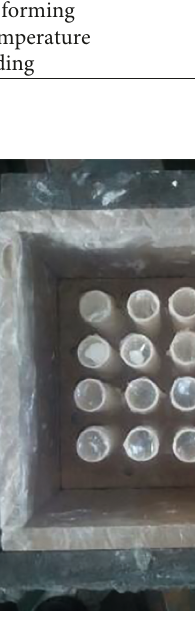
Figure 6: Devices for the silicone